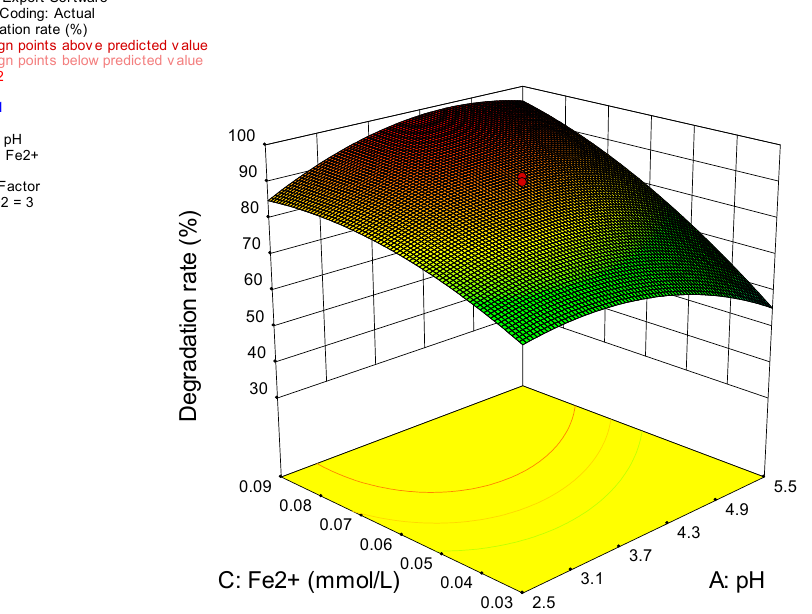
Water 2019 , 11 , 207 Figure 9. The influence of pH and Fe 2+ concentration on trimethoprim degradation.